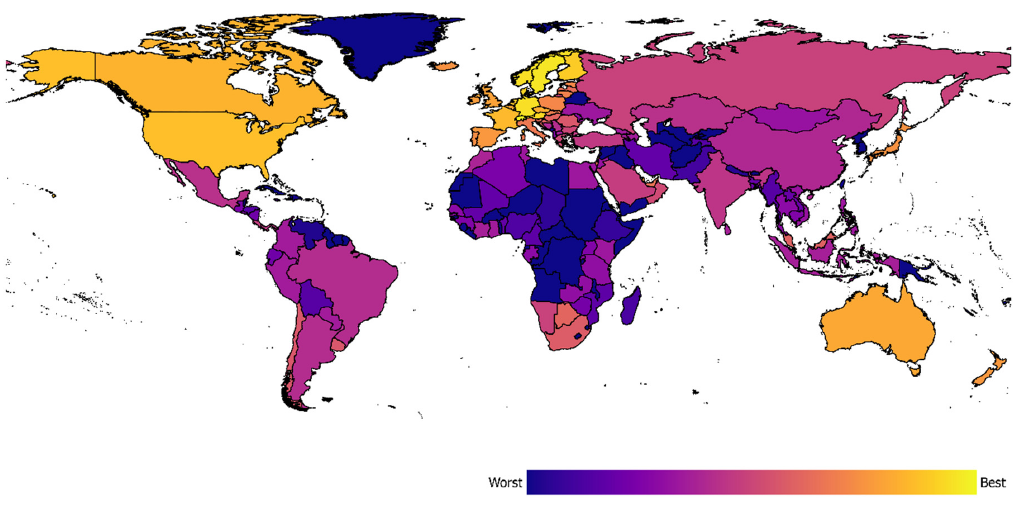
Figure 9. Global view on the resilience dimension.